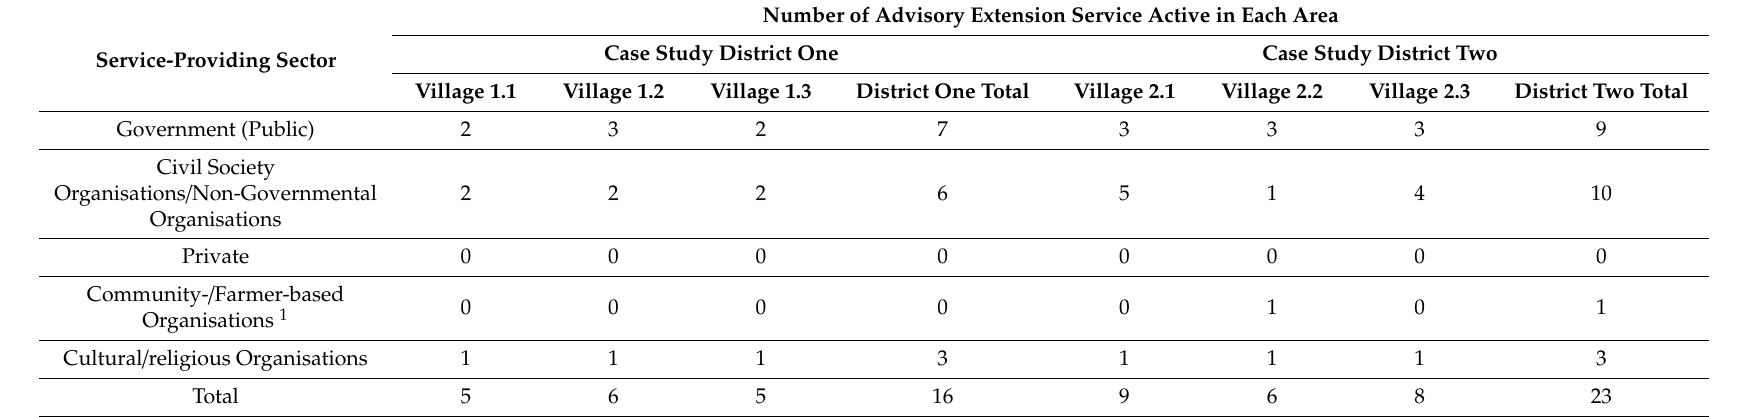
Table 1. Advisory Extension Services (AES) in the Case Study Locations (Questionnaire Survey).